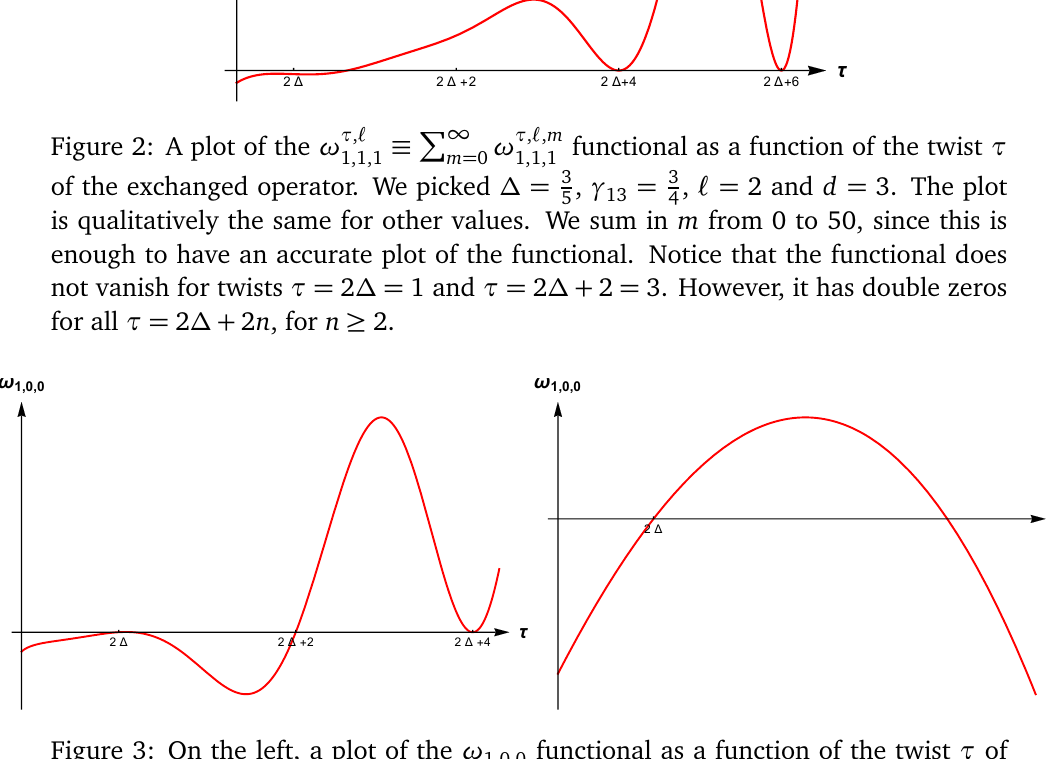
Figure 3: On the left, a plot of the ω functional as a function of the twist τ of 1,0,0 = 1 the exchanged operator. We picked ∆ = 1.1, γ , (cid:96) = 2 and d = 4. The plot 13 3 is qualitatively similar for other values. We sum in m from 0 to 50, since this is enough to have an accurate plot of the functional. Notice that the functional has single zeros for twists τ = 2 ∆ = 2 (though it is not very clear from the left plot) and τ = 2 ∆ + 2 = 4. However, it has double zeros for all τ = 2 ∆ + 2 n , where n ≥ 2. On the right, we zoom in to the region around τ = 2 ∆ , so that we can observe the single zero at τ = 2 ∆